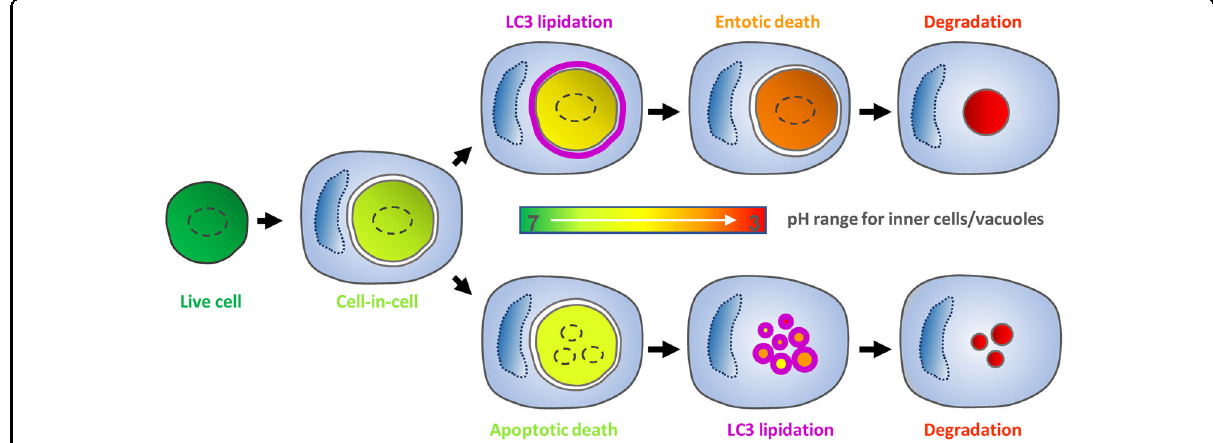
Fig. 6 Schematic demonstration of pH dynamics along with typical LC3 lipidation in two ways of inner cell death (entotic or apoptotic) mediated by CICs. Following the fully internalization to form CICs, the inner cells generally die via two mechanistically distinct ways. On the one hand, inner cells could be killed non-autonomously by the outer cells that are lysosome-dependent and preceded by a transient pre-death LC3 lipidation onto the entotic vacuole; on the other hand, inner cells may die cell-autonomously in a caspase-dependent apoptotic way, which is followed by a rapid post-death LC3 lipidation onto the apoptotic vacuoles. Under both circumstances, the pH of vacuoles that contain the internalized cells continues to decline, which may function to kill the inner cells and/or facilitate the clearance of dead corpses. Colors ranging from green to red indicate pH rang from neutral (about 7) to acidity (about 3). Purple ring indicates LC3 lipidation to